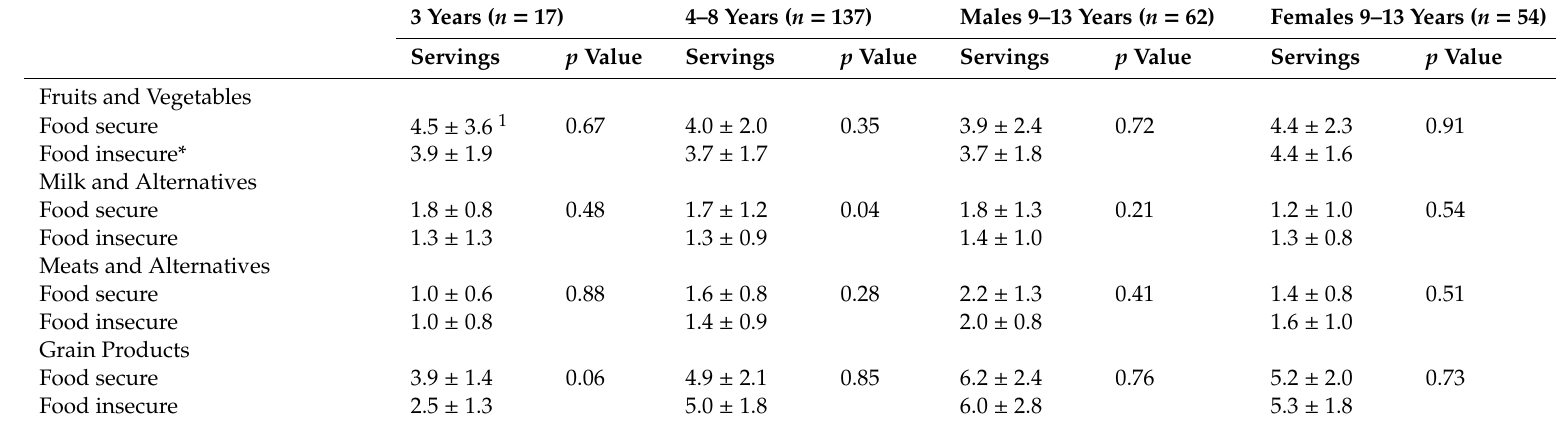
Table 5. Children’s consumption of foods from Canada’s Food Guide to Healthy Eating food groups from 24-h recall average in relation to household food security status